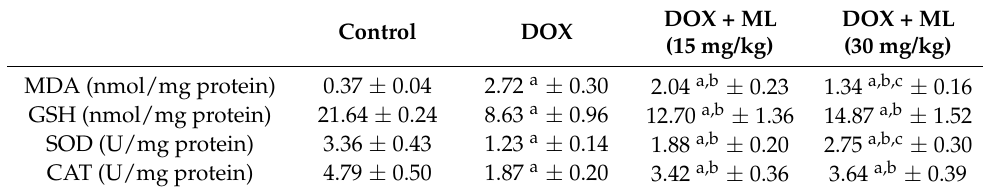
Table 1. Effect of ML on oxidative status in DOX-induced hepatotoxicity in rats. Control